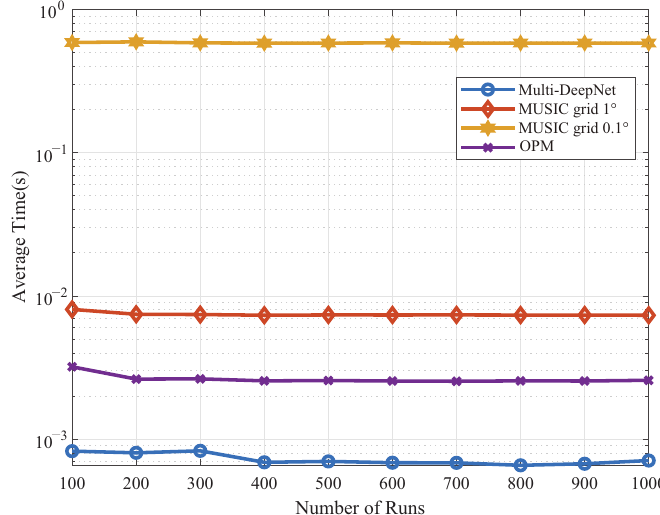
Figure 13. The average running time varies with the number of run trials.